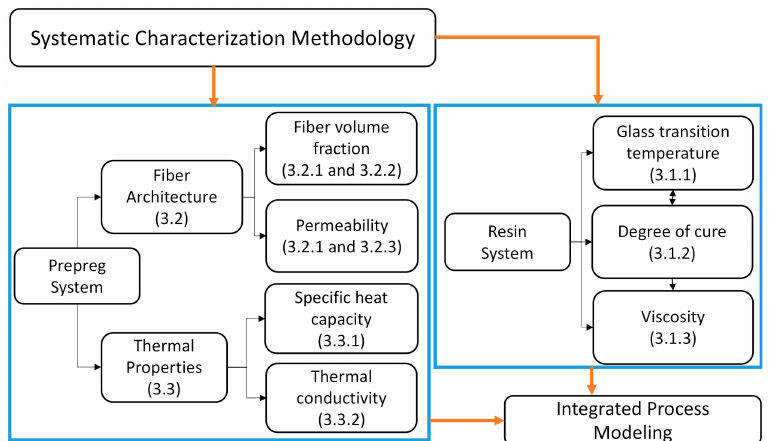
Figure 2. Systematic characterization road map of the prepreg material and its constituents with the numbers in parenthesis addressing the subsection with the corresponding